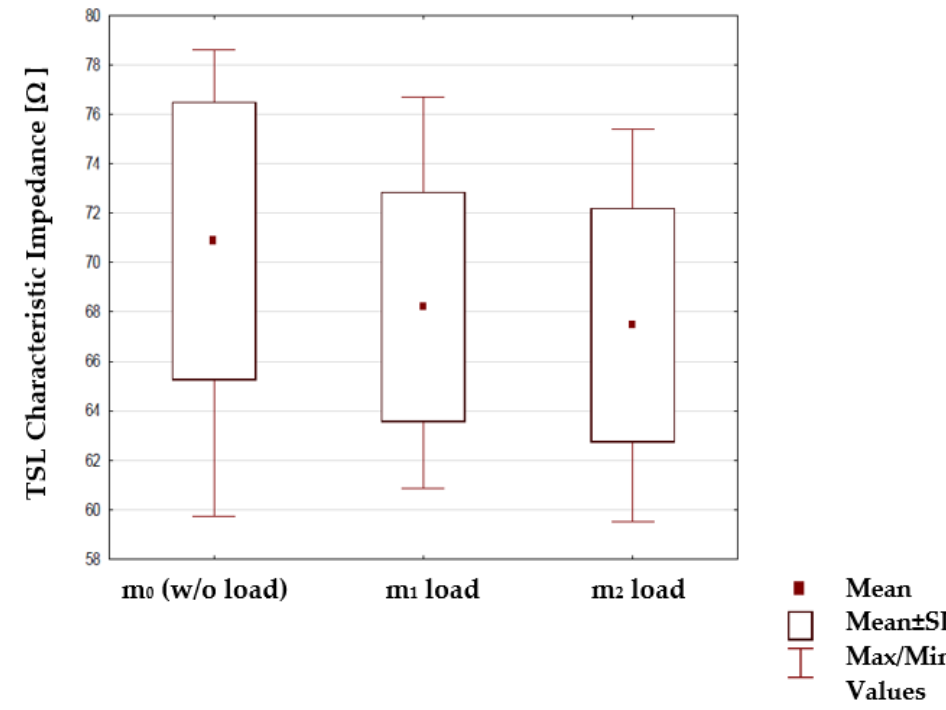
Figure 10. The characteristic impedance of lines under different loads for all sewed lines.